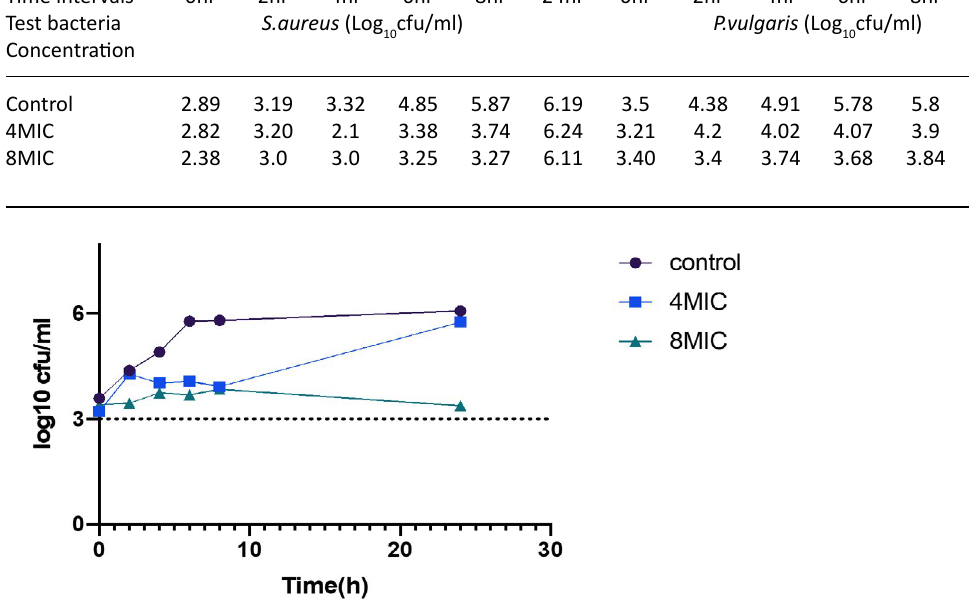
Table 4. Time kill profile of acetone extract of Terminalia catappa showing reduction of viable cell counts at different time intervals. Time